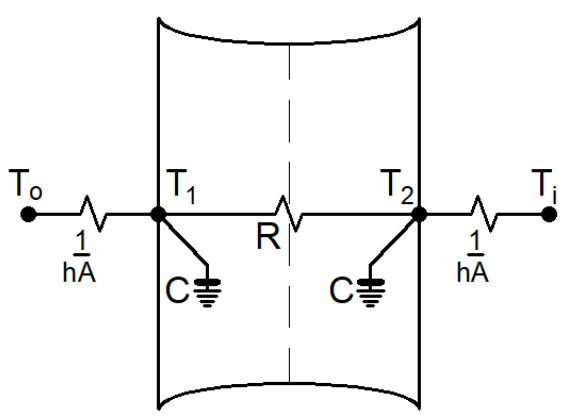
Figure 5. Two-node model of a single-layer partition for dynamic simulations (own elaboration based on [35]).